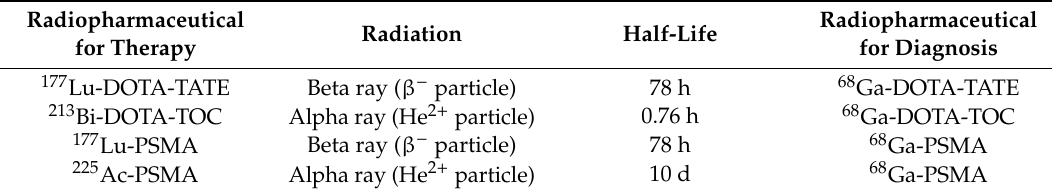
Table 2. Representative Pair of Radiopharmaceuticals for Theranostics.